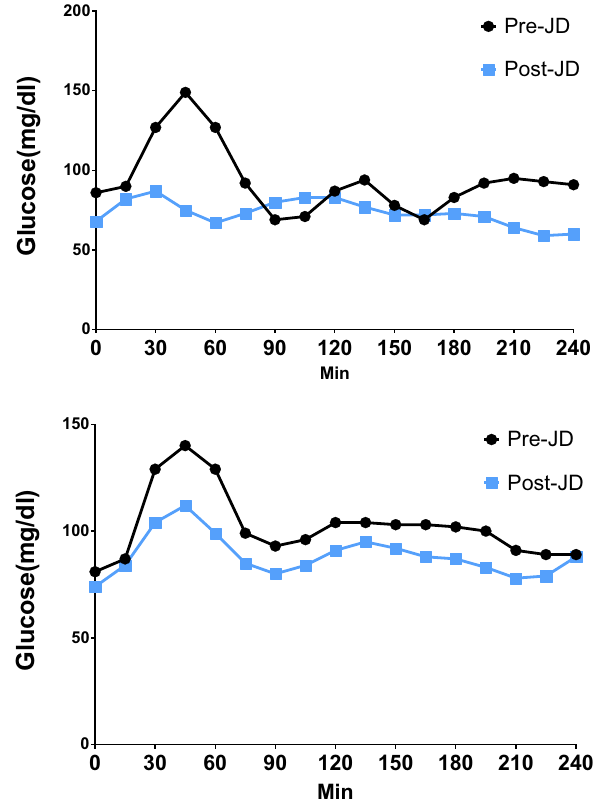
Figure 2. Oral glucose tolerance curves pre and post passive simulated jogging device. Representative 4 h Oral Glucose Tolerance Curves (OGTT) before (Pre-JD) and after 7 days of JD use (Post-JD) from two participants A, B.